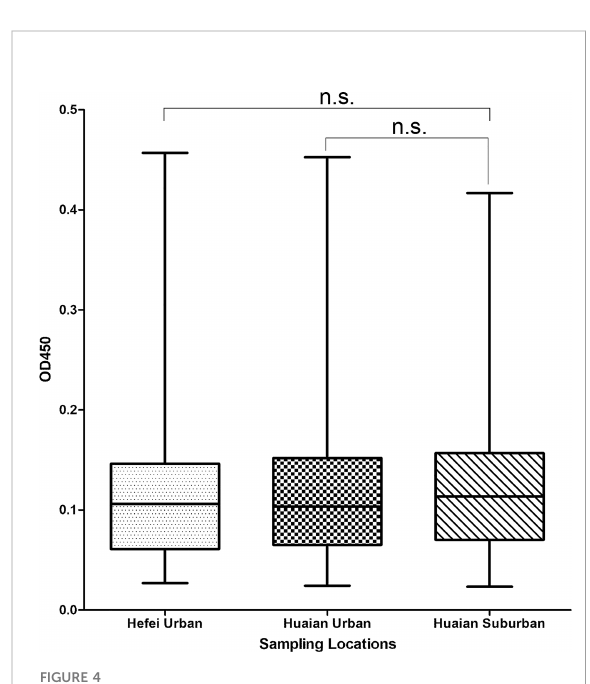
FIGURE 4 Box and whisker plot of OD450 values of the serum samples detected using ELISA. The box represents 25th to 75th percentile and the mean value (line in the middle of each box), and whisker shows the minimum and maximum values. The sampling locations were indicated. n.s., not signi fi